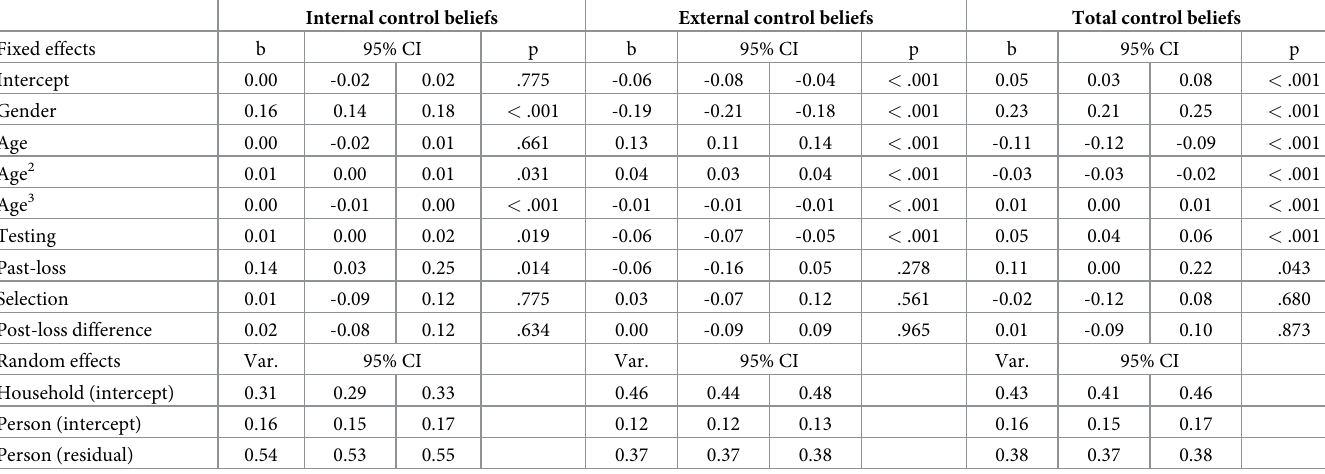
Table 5. Differences in perceived control between individuals who did ( N = 423) and did not ( N = 14,349) get divorced between 1991 and 1999 ( N =